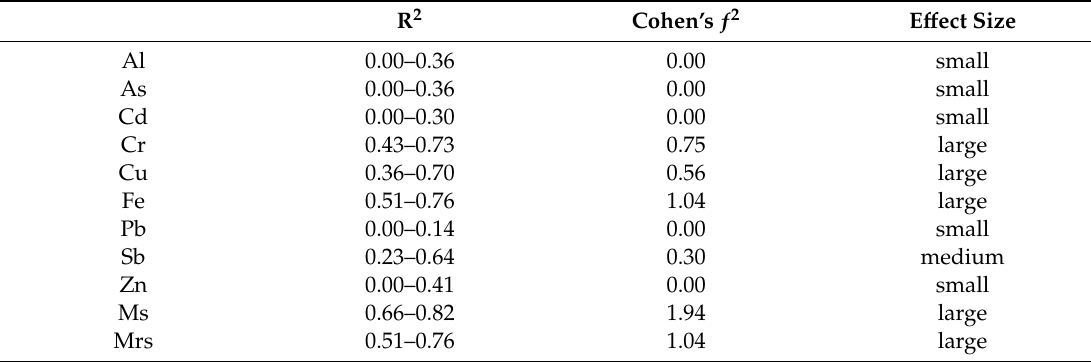
Table 3. Ninety-five percent credible intervals of the R 2 values, Cohen’s ƒ 2 and magnitude of the e ff ect size between magnetic susceptibility and chemical elements as well as other magnetic